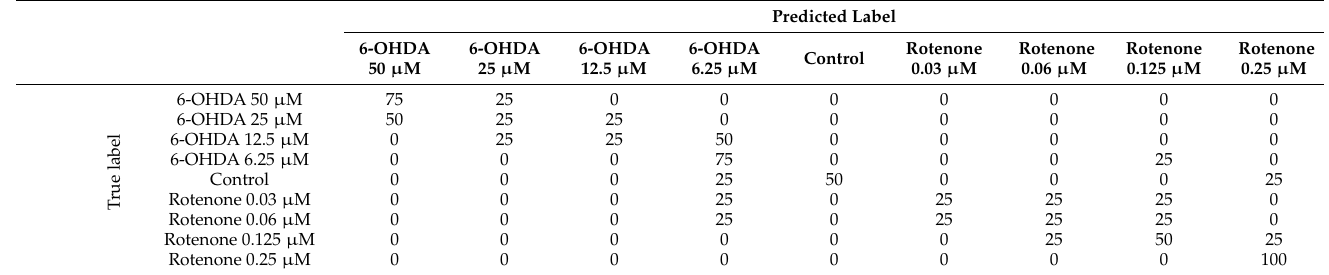
Table 1. Decision tree confusion matrix. The test metrics of the decision tree are the following: {Accuracy: 0.5; Precision: 0.52; Recall; 0.5; F1-score: 0.48; AUC: 0.74}. Values on the confusion matrix correspond to test results and are presented as the percentage of the proportion of the actual